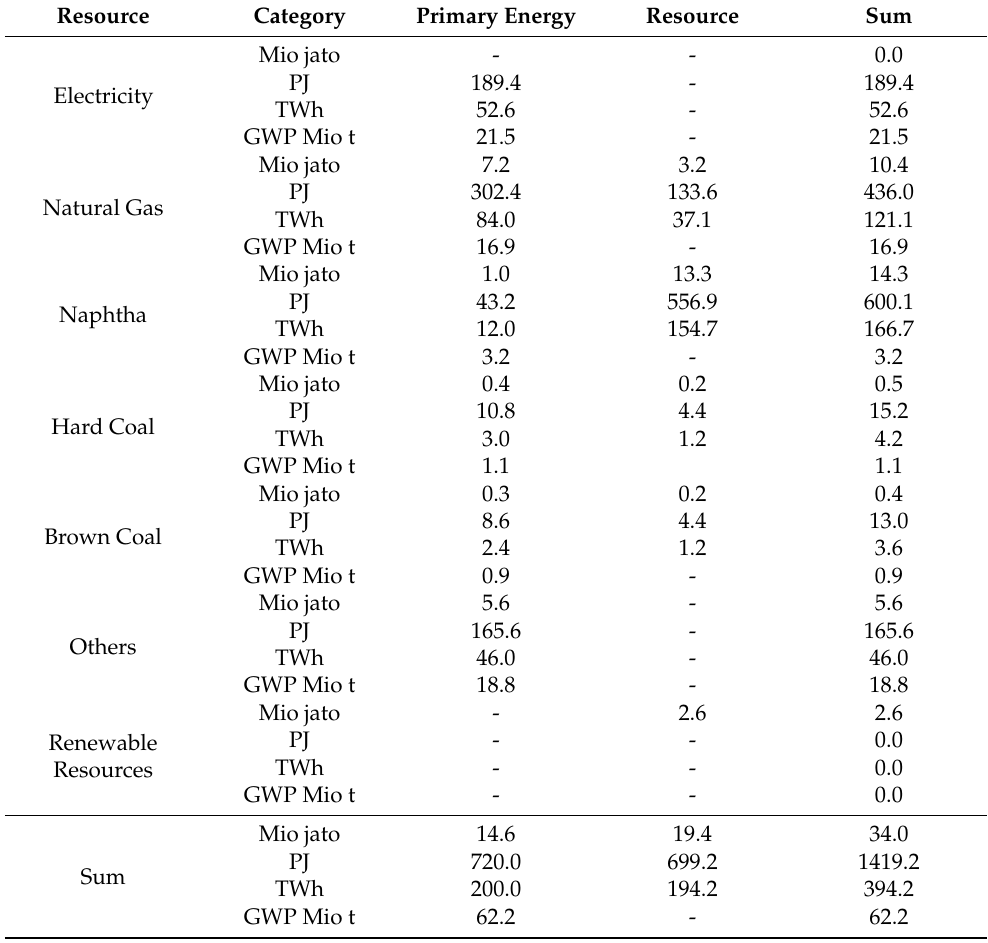
Table 2. Inlet mass and energy streams of German Chemical–Pharmaceutical Industry in 2021. Resource Category Primary Energy